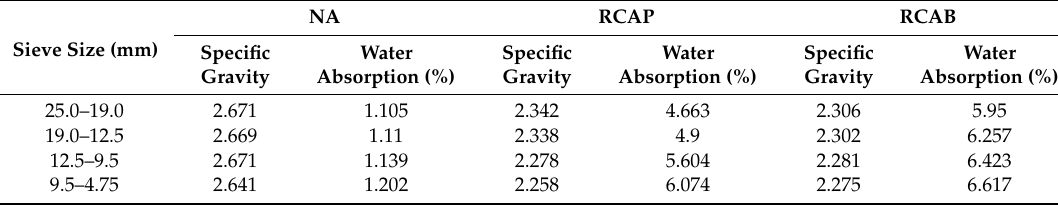
Table 5. Specific gravity and water absorption of coarse NA, RCAP, and RCAB.